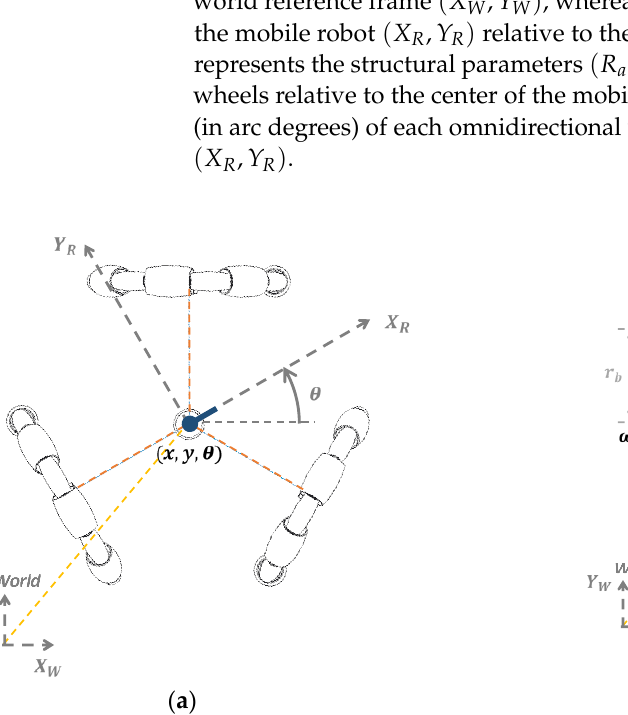
Figure 2. ( a ) Representation of the location of the center of the mobile robot (𝑥, 𝑦) and absolute angular orientation (𝜃) of the omnidirectional mobile robot relative to the world reference frame (𝑋 𝑊 , 𝑌 𝑊 ) . The reference frame (𝑋 𝑅 ,𝑌 𝑅 ) is the mobile frame of the mobile robot, where the axis 𝑋 𝑅 depicts the front of the mobile robot. ( b ) Representation of the parameters of a motion vector (𝑣, 𝛼, 𝜔) . (𝑅 𝑎 ,𝑅 𝑏 ,𝑅 𝑐 ) are the radial distances of each omnidirectional wheel relative to the center of the mobile robot, (𝛿 𝑎 , 𝛿 𝑏 ,𝛿 𝑐 ) are the angular orientations of the wheels relative to the mobile robot reference frame (𝑋 𝑅 , 𝑌 𝑅 ) , and (𝜔 𝑎 , 𝜔 𝑏 ,𝜔 𝑐 ) are the representation of the angular rotational speed of the wheels.